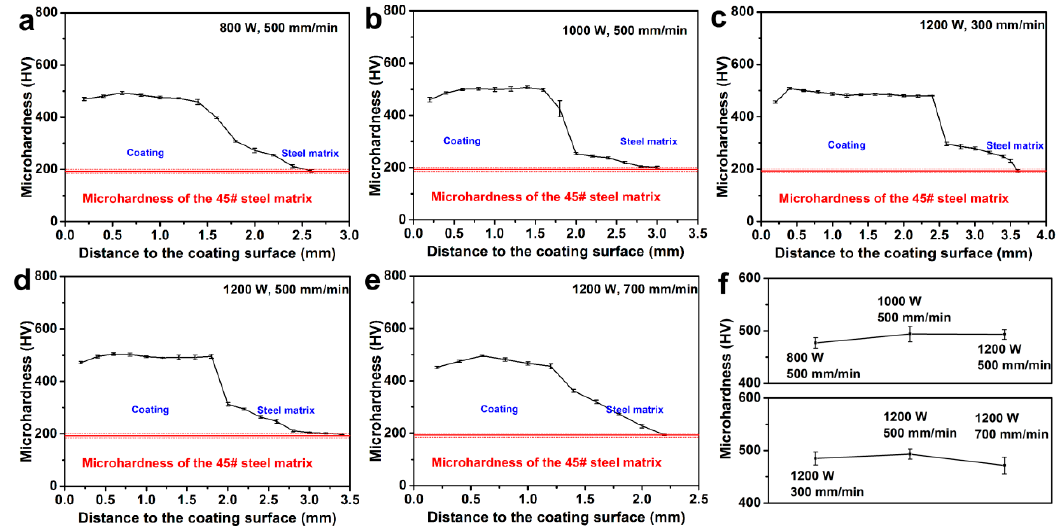
Figure 6. The hardness distribution of the Fe–Si–Al coating ( a ) specimen 1, ( b ) specimen 2, ( c ) specimen 3, ( d ) specimen 4, ( e ) and specimen 5 and ( f ) the average microhardness of the coatings.